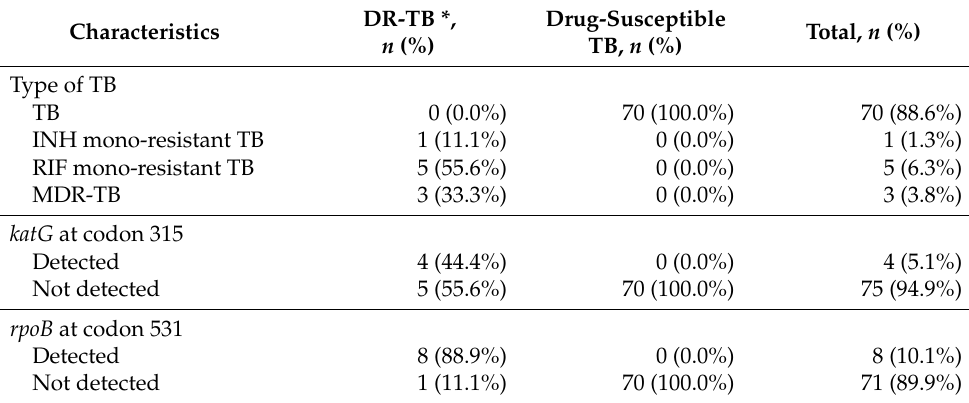
Table 1. Characteristics of DR-TB and drug-susceptible TB.